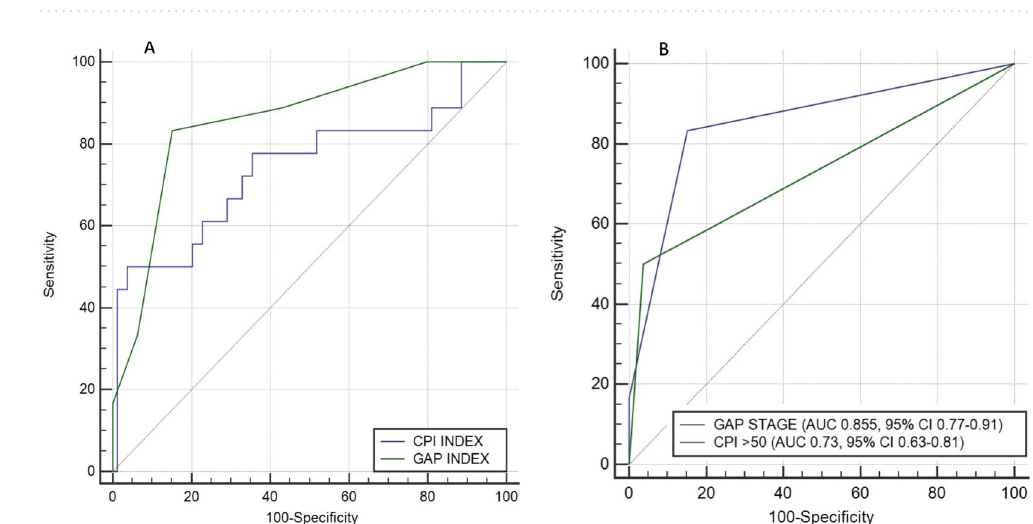
Figure 6. ( A ) ROC curve for CPI and GAP indexes. For CPI, the AUC was 0.742 and the best cut-off point for predicting survival was 50.58 (sensitivity of 50% and specificity of 96.2%). The AUC for GAP ROC curve was 0.857 with a best cut-off point of 3 (sensitivity 83.3% and specificity 85.2%). ( B ) Receiver operator characteristic (ROC) curves for GAP stage (I, II and III) and CPI (with a cut-off point of 50) to predict mortality in AR-ILD patients.